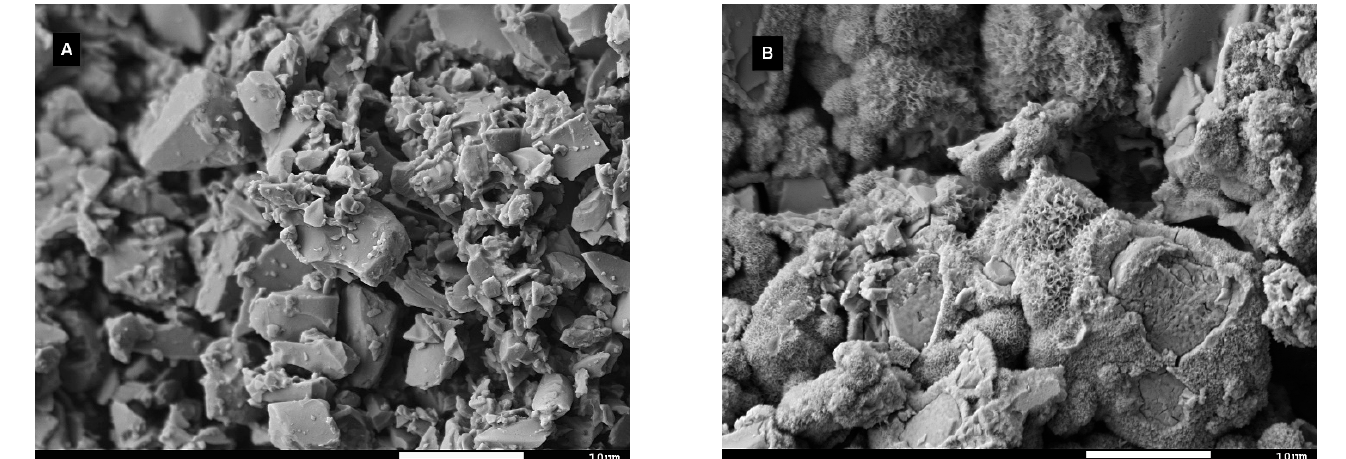
Figure 9. SEM micrographs ( A ) of VB glass powder before ( B ) testing and after the flow-through test in the SBF at a pH of 7.4.